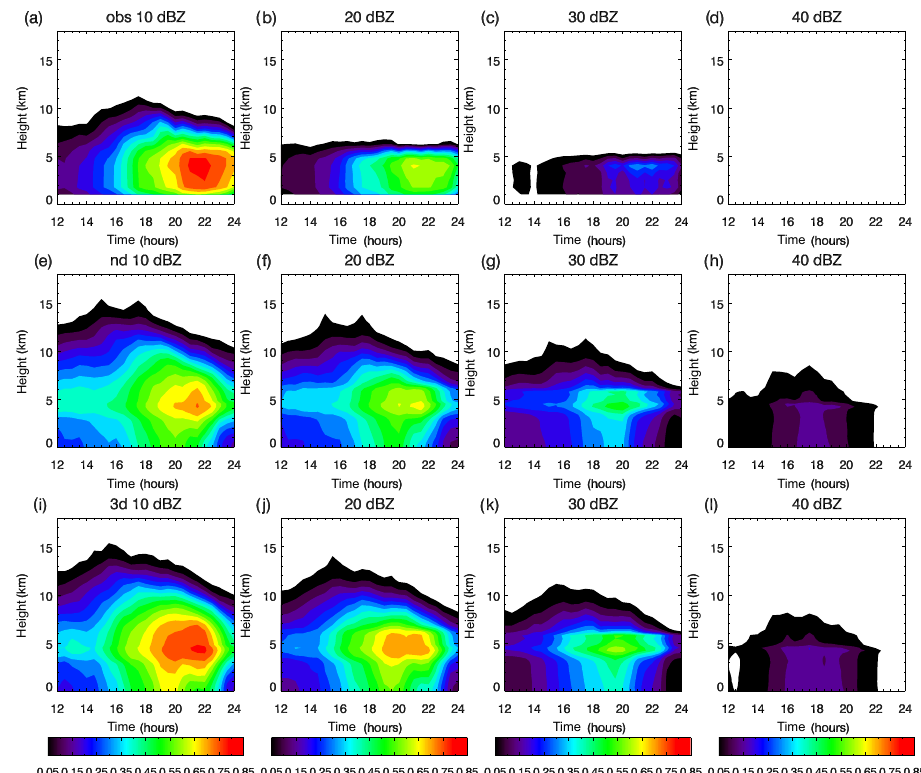
Figure 6. The observed (top panels), simulated by the control model (middle panels) and with a change to the turbulent mixing (lower panel) fraction of radar-detected area covered by reflectivities greater than (a, e, i) 10, (b, f, j) 20, (c, g, k) 30 and (d, h, l) 40dBZ for 12:00–24:00UTC on 18 February